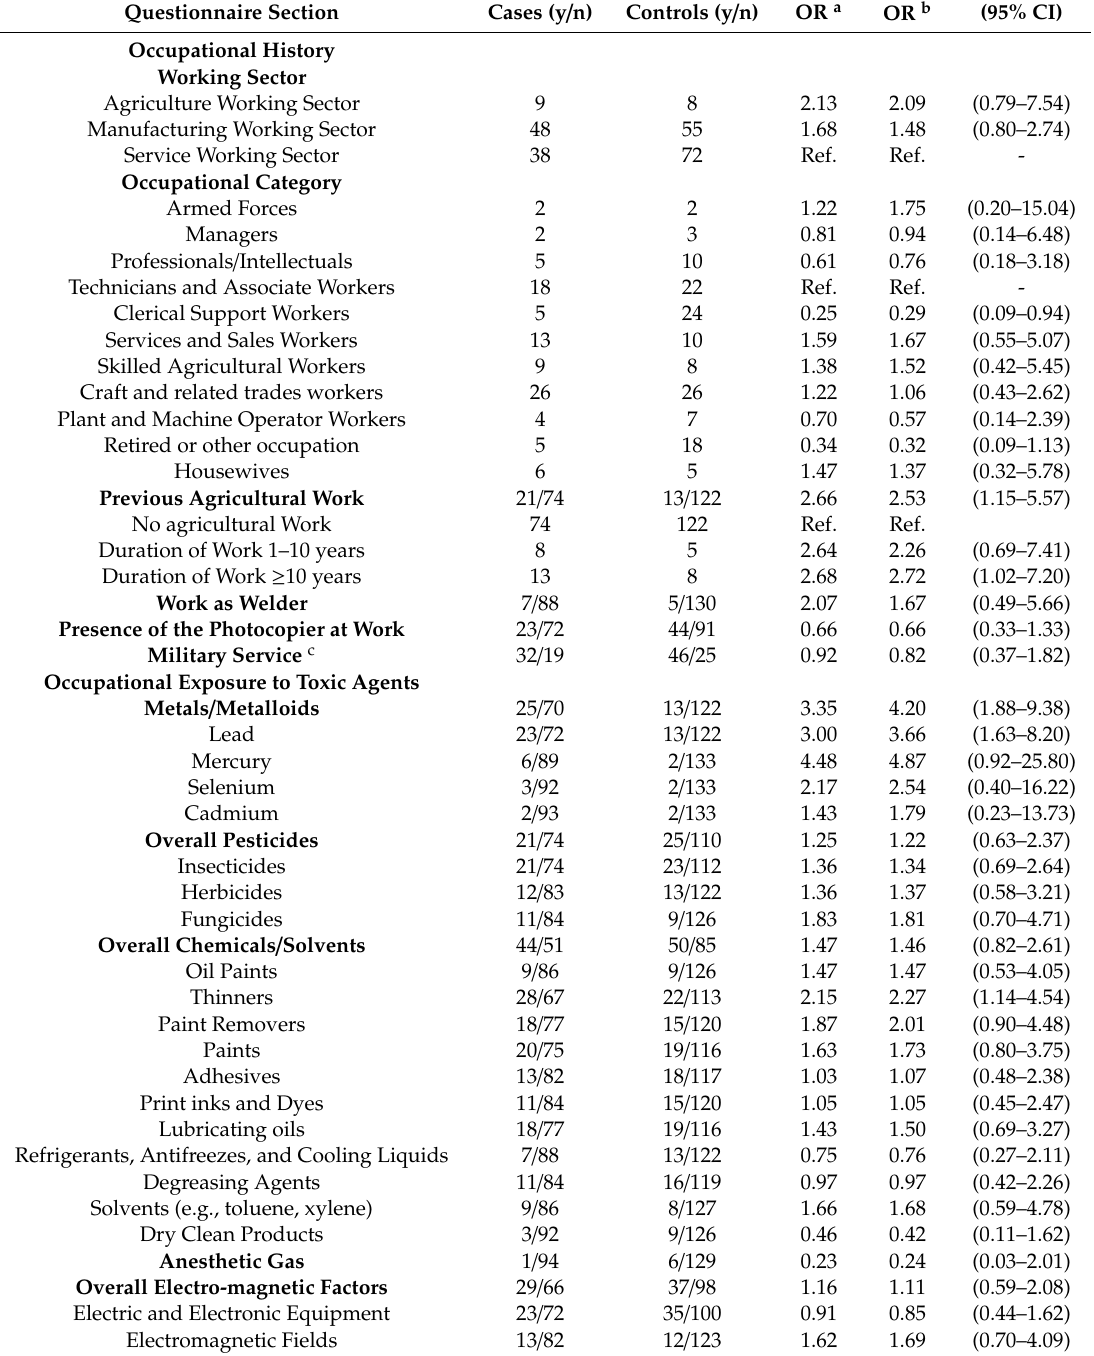
Table 2. Odds ratio (OR) with 95% confidence interval (CI) of ALS risk according to occupational history and